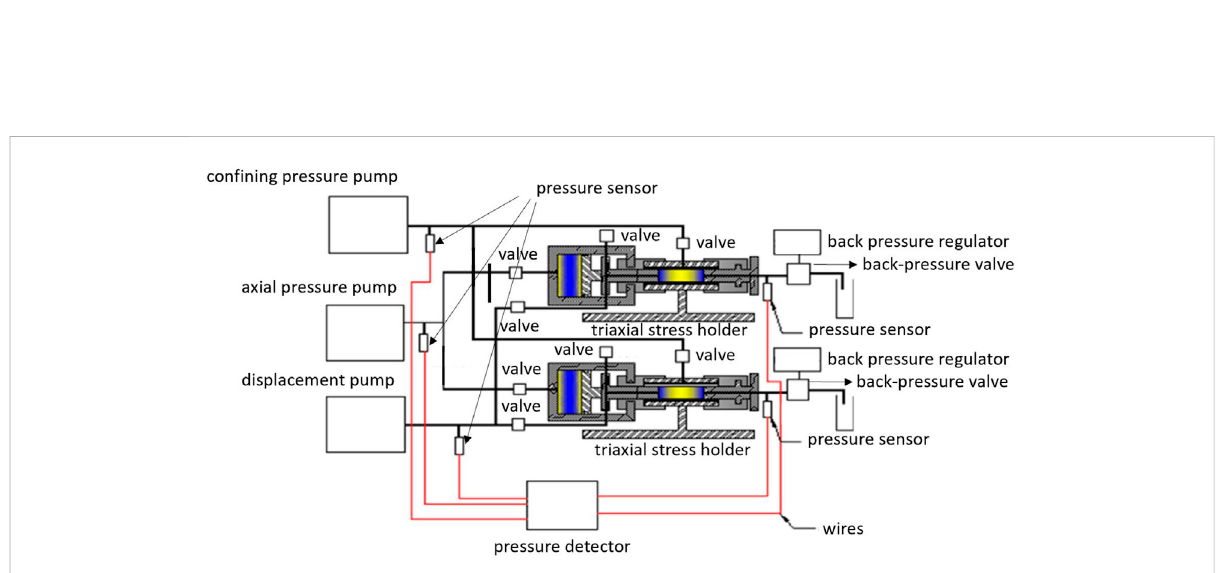
FIGURE 16 Rock stress sensitivity test fl ow graph of parallel